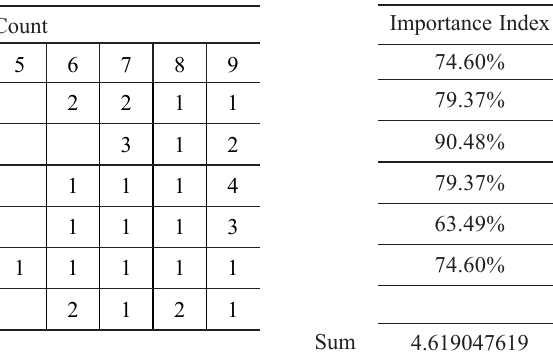
Table 2. Criteria index